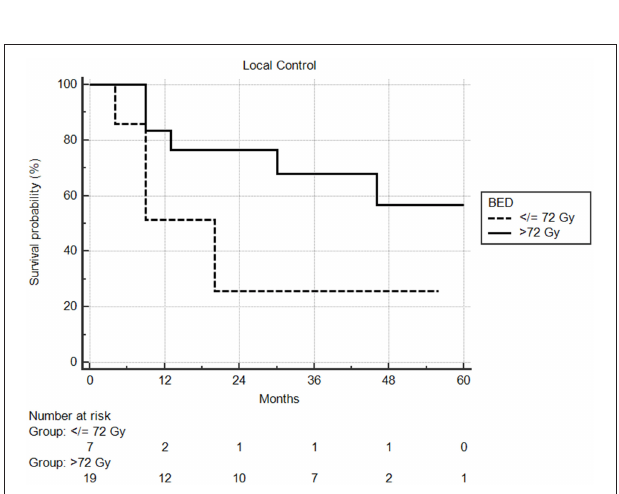
FIGURE 3 | Local control by BED using a cutoff of 72Gy. One year local control was 90% compared to 57%, in favor of higher biologic